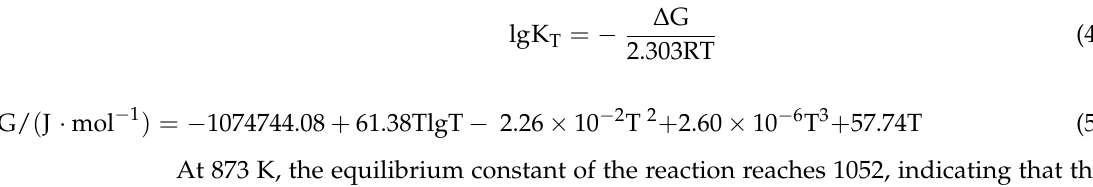
Figure 2. SEM image of the sublimation–crystallization product.